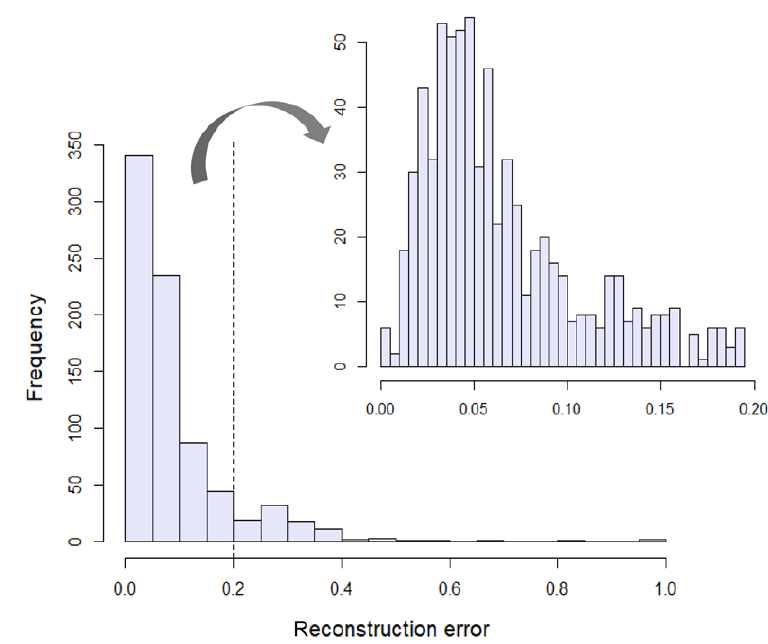
Figure 5. Distribution of the reconstruction error Table 3. Sites with the two highest and two lowest reconstruction